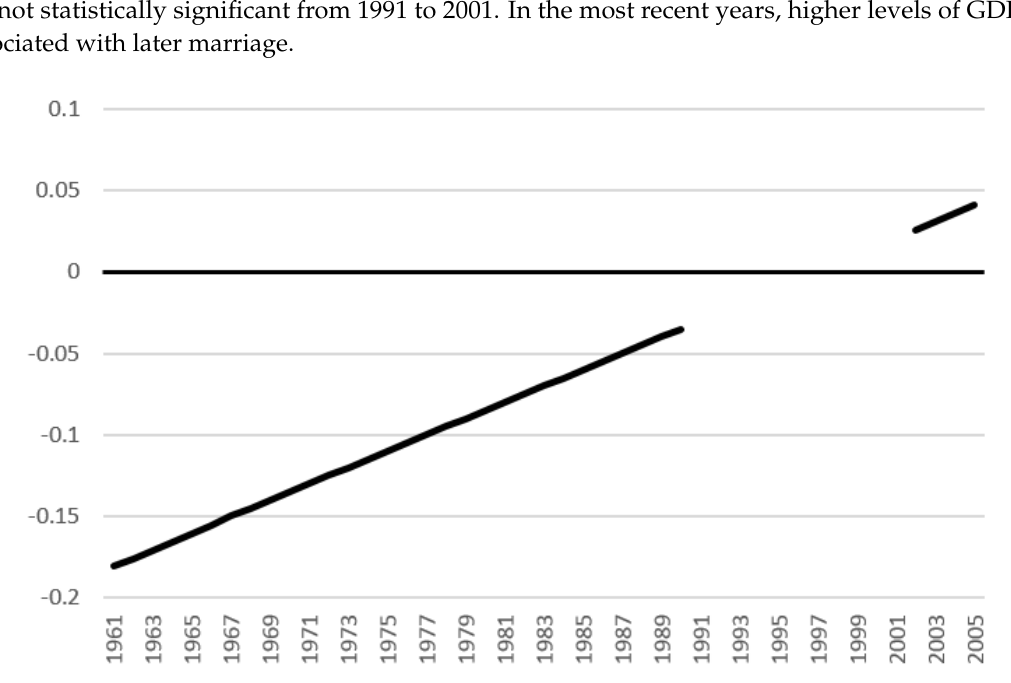
Figure 2. Change in the Association between GDP and Average Age at First Marriage (Effect of 1-unit change is shown). Note: Any non-linearity is due to rounding errors. Only effects that are significant at the 0.05 level are displayed.